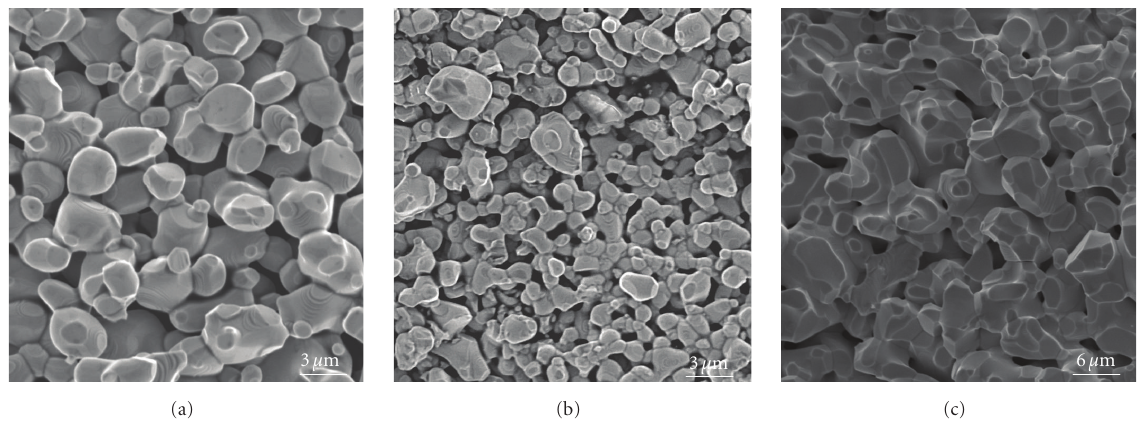
Figure 1: Fracture surfaces for monolithic (a) ZrC, (b) HfC and (c) TaC showing a high level of residual porosity.